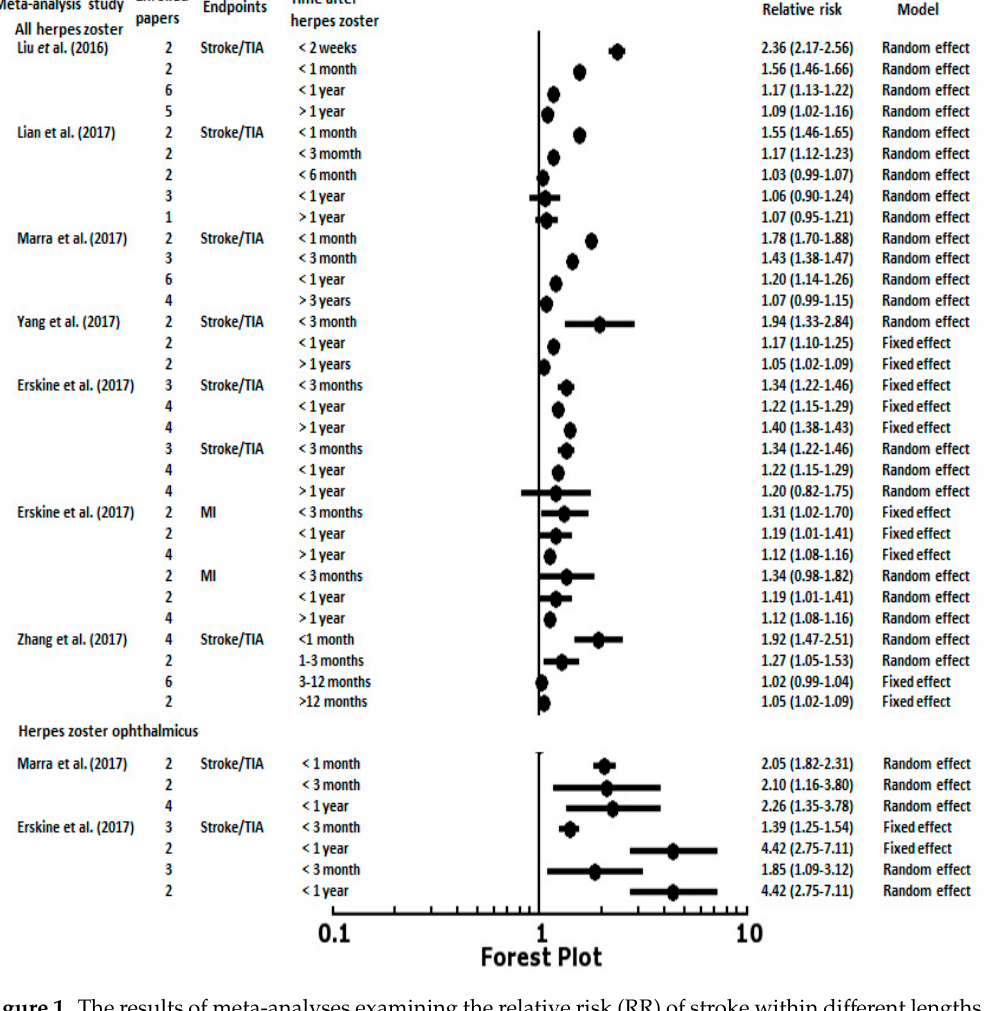
Figure 1. The results of meta ‐ analyses examining the relative risk (RR) of stroke within different lengths of follow ‐ up after herpes zoster episodes. TIA, transient ischemic attack; MI, myocardial infarction.